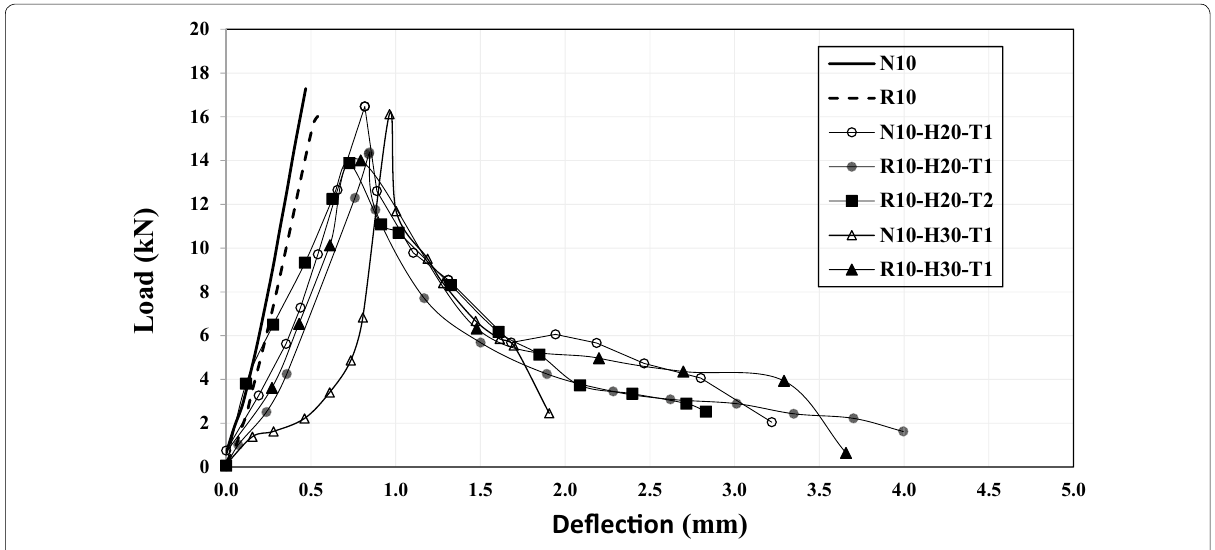
Fig. 7 Load–deflection curves of the standard beams; Group 1, MSA